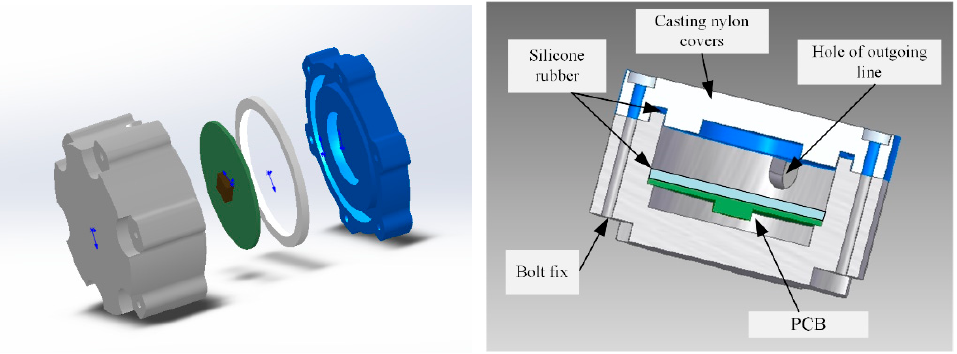
Figure 2. Composition of acceleration sensing node.